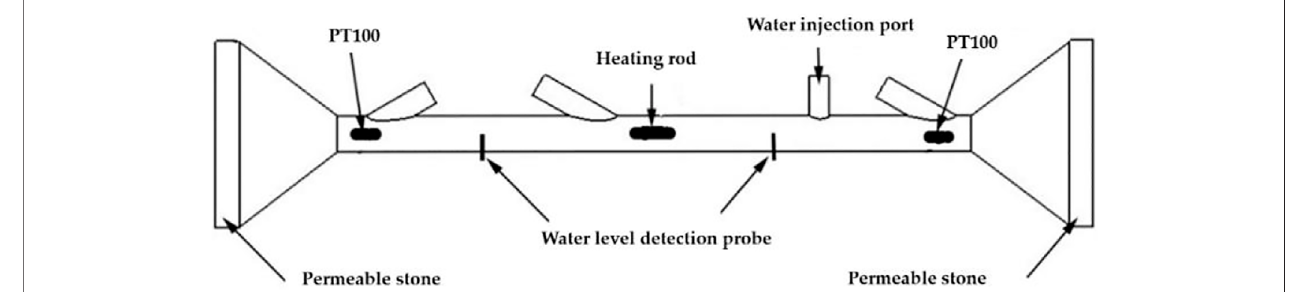
FIGURE 1 | Sensing structure of thermal seepage